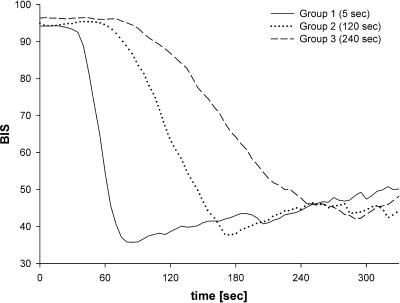
Mean BIS Developing for Each of the Three GroupsThe figure shows the sharp BIS decrease and the fast reaching of BISmin in group 1. In contrast to group 1, in group 3 the BIS curve runs very flat and it takes a longer time to reach BISmin.